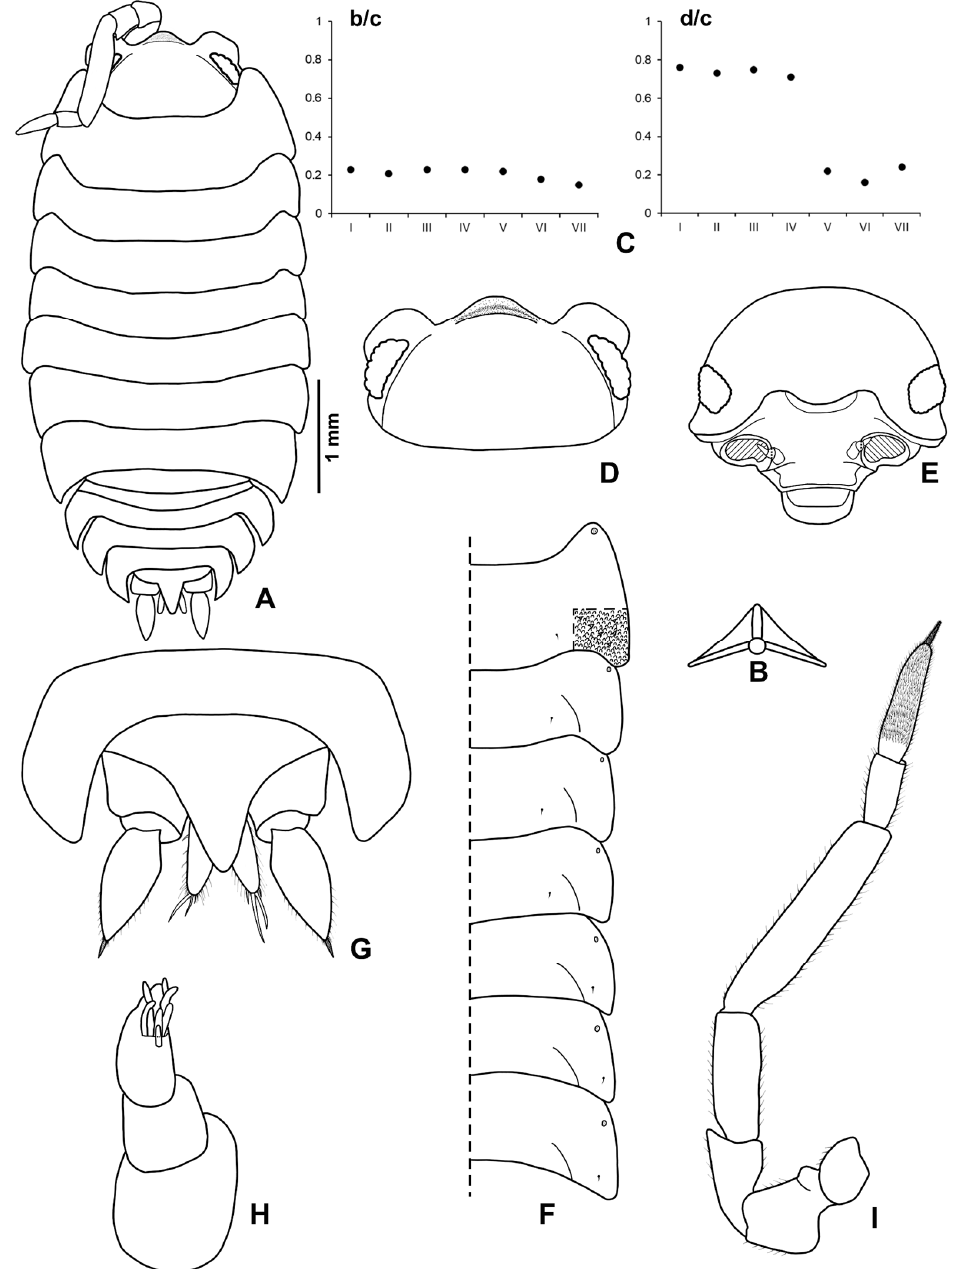
Figure 10. Porcellio incavatus sp. n., paratype ♂ from Santo Stefano d’Aveto. ( A ) Specimen in dorsal view. ( B ) Dorsal scale-seta. ( C ) Coordinates of noduli laterales. ( D ) Cephalon, dorsal view. ( E ) Cephalon, frontal view. ( F ) Right side of pereon showing disposition of noduli laterales and gland pores. ( G ) Pleonite 5, telson and uropods, dorsal view. ( H ) Antennula. ( I ) Antenna.